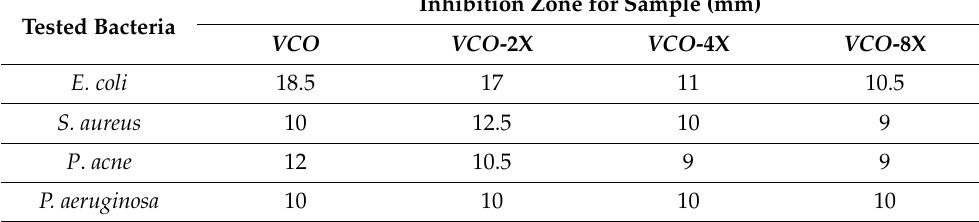
Table 6. Inhibition zone of antibacterial